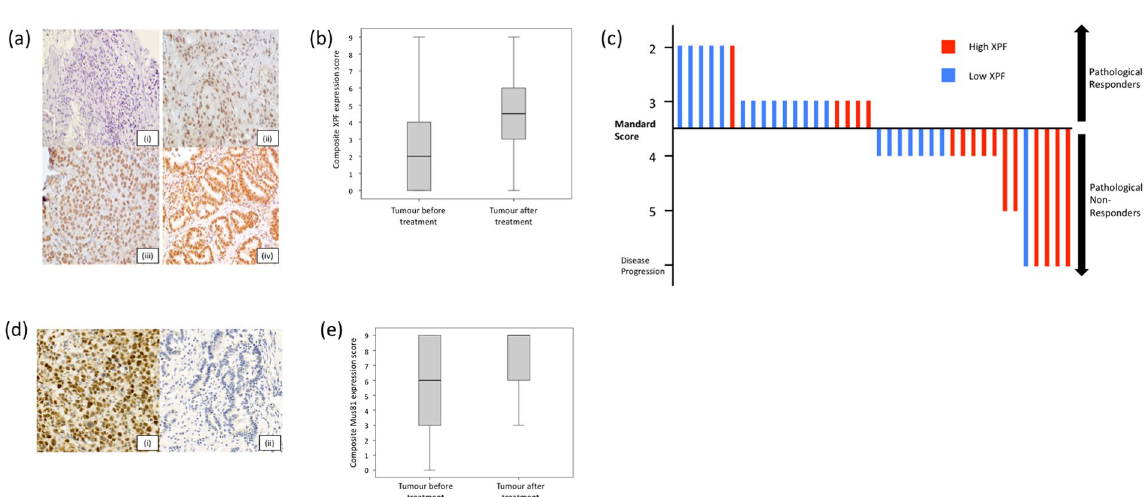
Figure 2. XPF and MUS81 protein levels in EAC tissue by immunohistochemistry. ( a ) Esophageal adenocarcinoma pre-treatment biopsies stained for XPF protein, photographed at x20 magnification; intensity scores (i) 0, (ii) 1, (iii) 2 and (iv) 3. ( b ) Significant increase in XPF protein levels when pre-treatment biopsies were compared with post-treatment resection samples following 2 cycles of oxaliplatin-fluorouracil chemotherapy (median pre-treatment 2, IQR 0–4; median post-treatment 4.5, IQR 3–6; P = 0.004, Wilcoxon signed rank test). ( c ) A waterfall plot of the association between pre-treatment tumour XPF level and pathological response following oxaliplatin-chemotherapy. Each line represents the degree of